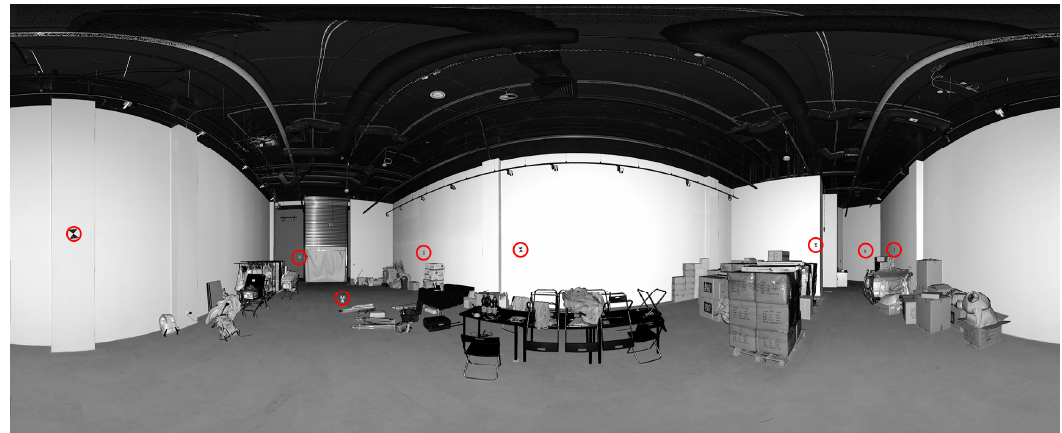
Figure 9. The example of the point cloud in the spherical projection of test site IV: “Empty shop (shopping mall)” with marked check points (red circles).